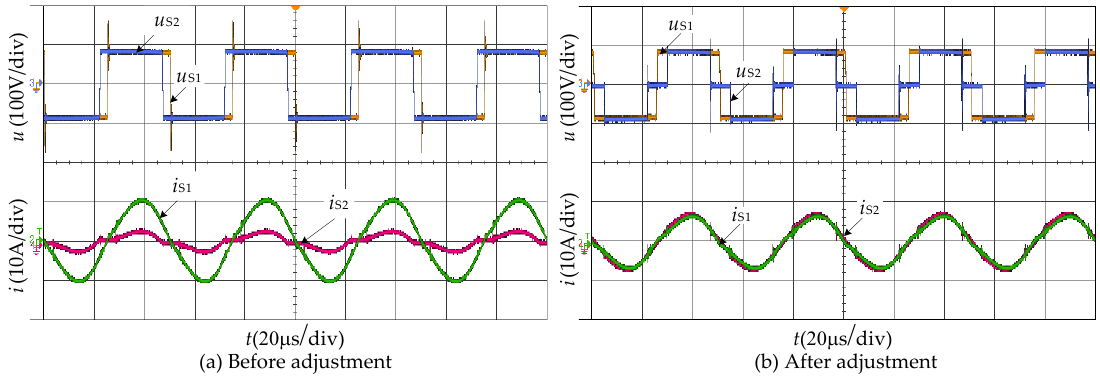
Figure 15. Input voltage and current waveforms of the receivers when the load is 10 Ω and δ equals 175 mm. Table 2. The output power of receivers before and after the current control applied.